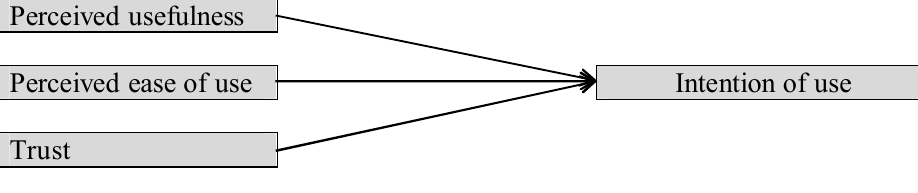
Fig. 1. The proposed study (Nor et al., 2010)